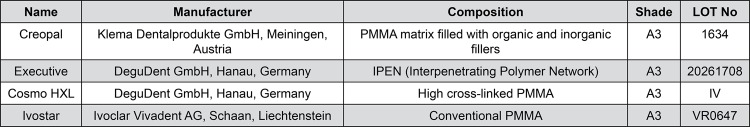
Name, manufacturer, composition, shade, and batch number of the denture teeth used in the study